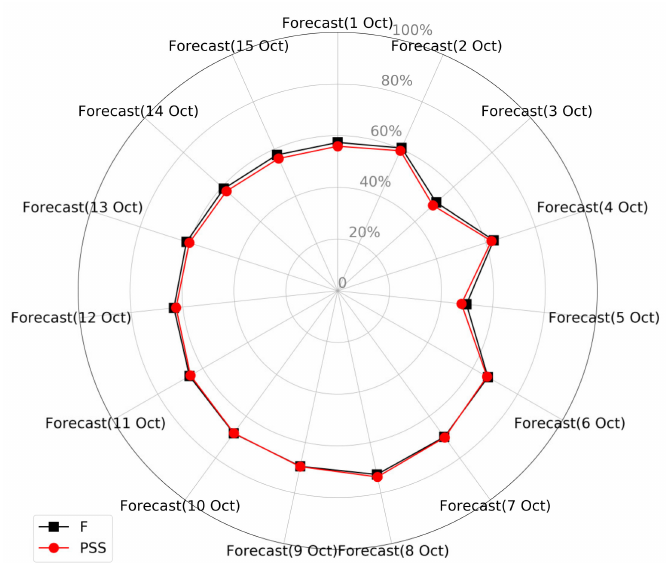
Figure 6. The fit ( F ) and Peirce’s skill score ( PSS ) of the simulated inundated